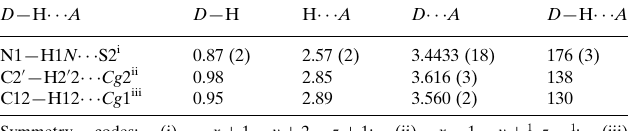
Hydrogen-bond geometry (A˚ , (cid:2)